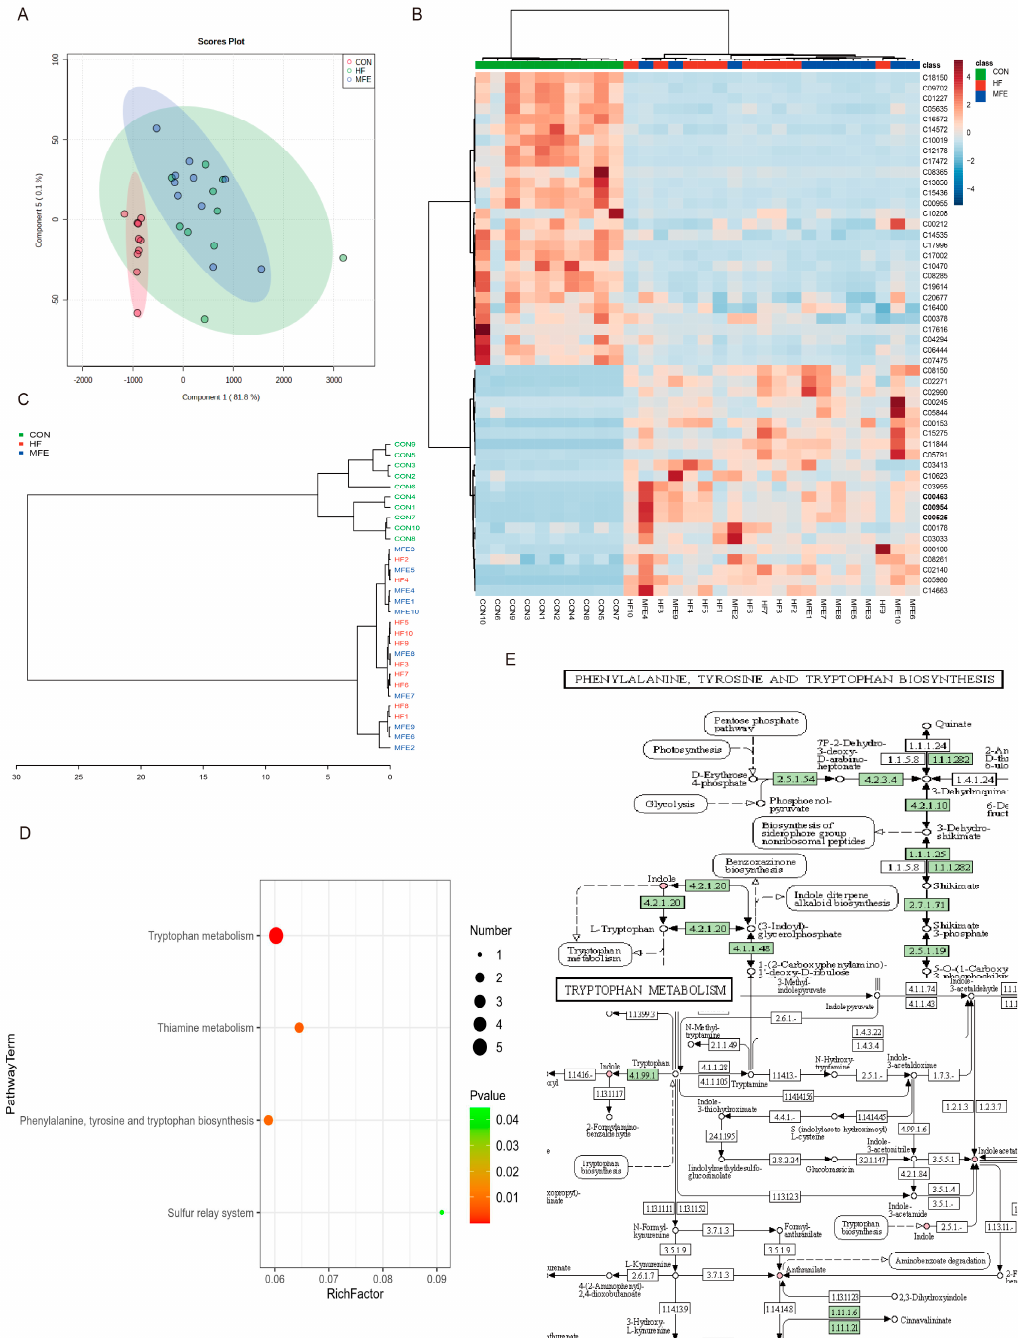
Figure 4. Effects of MFE on gut metabolites. ( A ) Partial least-squares discriminant analysis (PLS-DA) of metabolites of three groups (CON, HF, and MFE). ( B ) Heat map for metabolite enrichment change analysis (Top50) of three groups. ( C ) Phylogenetic tree of correlation between samples of metabolites in three groups (CON, HF, and MFE). ( D ) The pathway enrichment analysis of metabolites. ( E ) KEGG map shows metabolites in enriched pathways. Data are shown as mean ± SD. (For each group, n = 10).